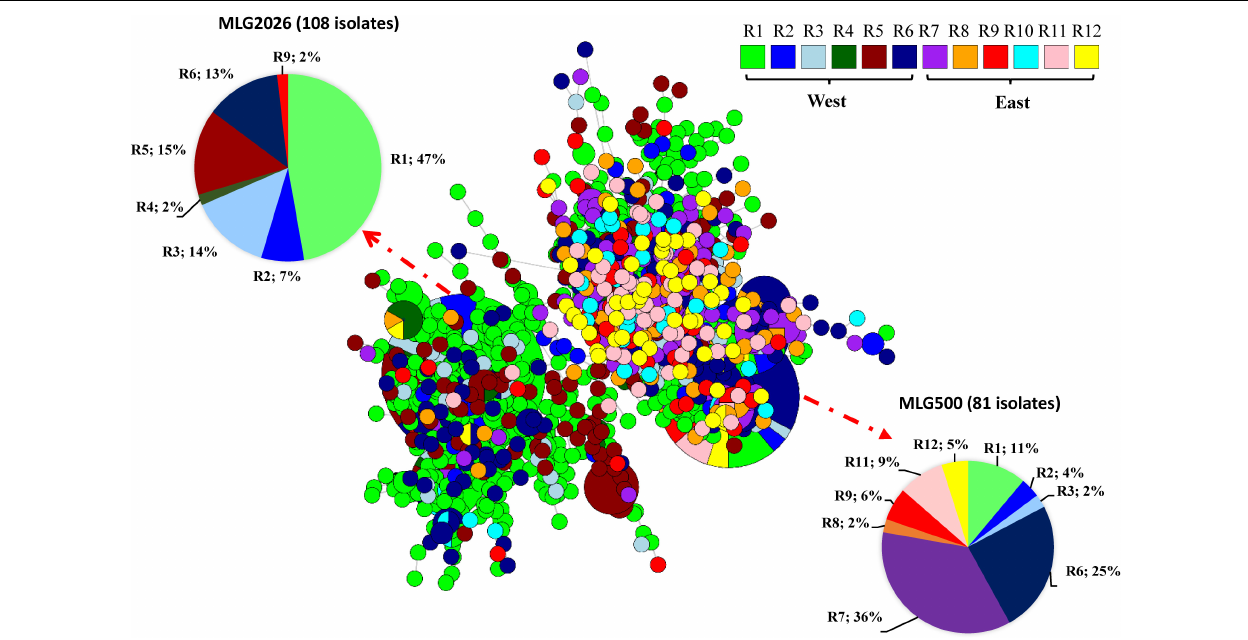
FIGURE 1 | Minimum spanning network representing relationships among multilocus genotypes (MLGs) of Puccinia striiformis f. sp. tritici identified from 12 epidemiological regions in the United States. Each node represents a different MLG. The size of a node represents the number of isolates in the same MLG. Node colors represent population membership in